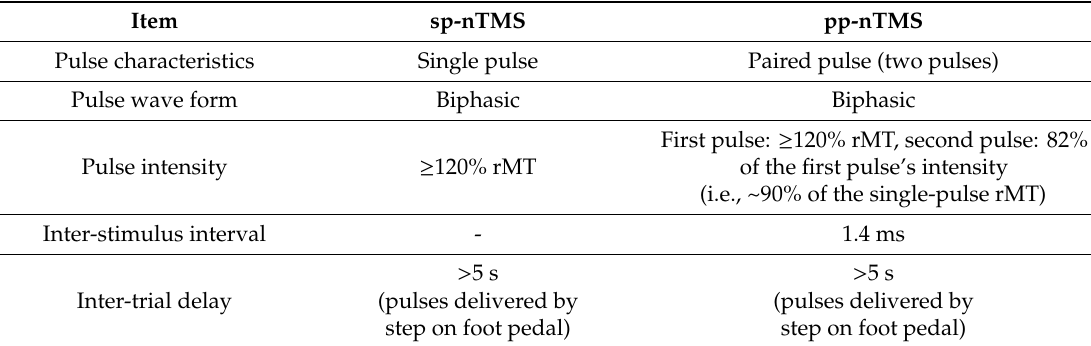
Table 1. Stimulation